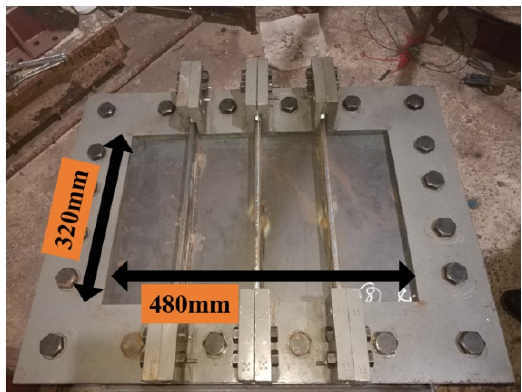
Figure 4. Fixed stiffened plate, with bolt connection.